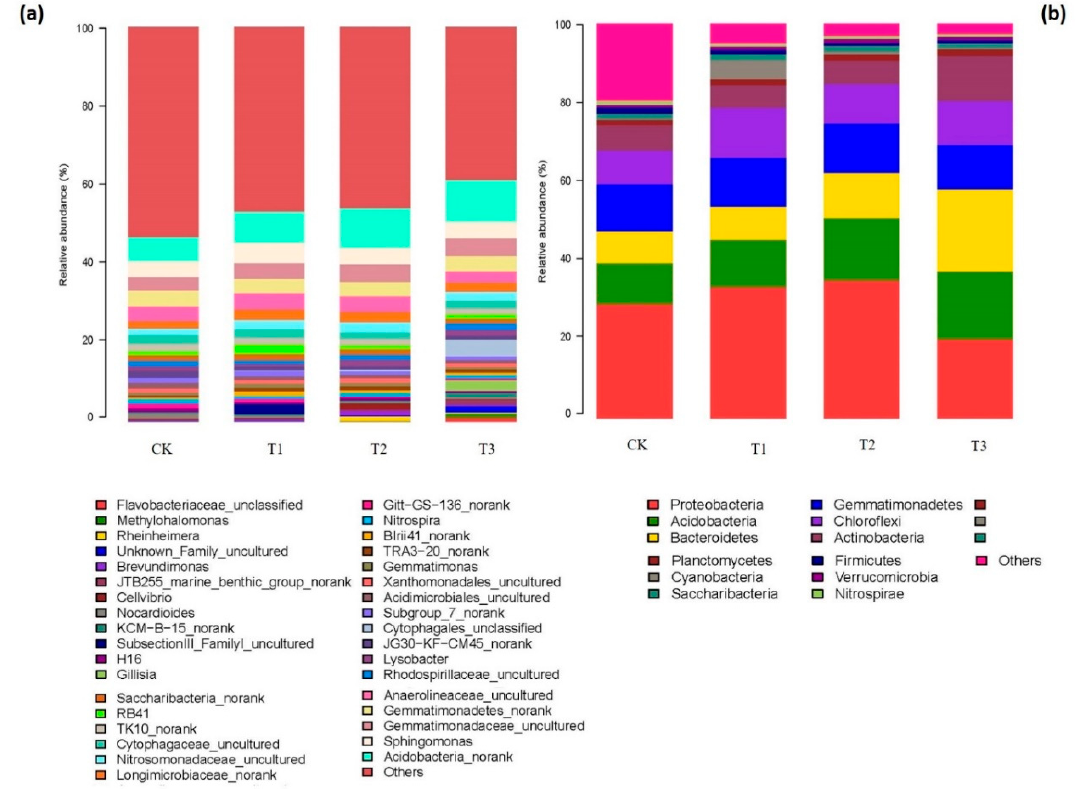
Figure 3. ( a ) Relative abundances (%) of bacterial community composition at the genus level. ( b ) Relative abundances of community proportions of bacteria samples at the phylum level under different treatments.